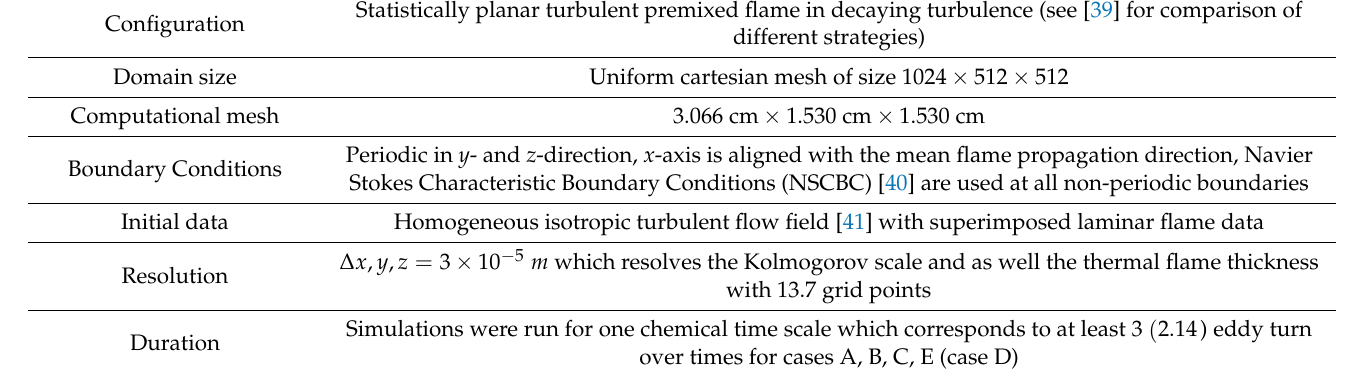
Table 2. Details of computational configuration.